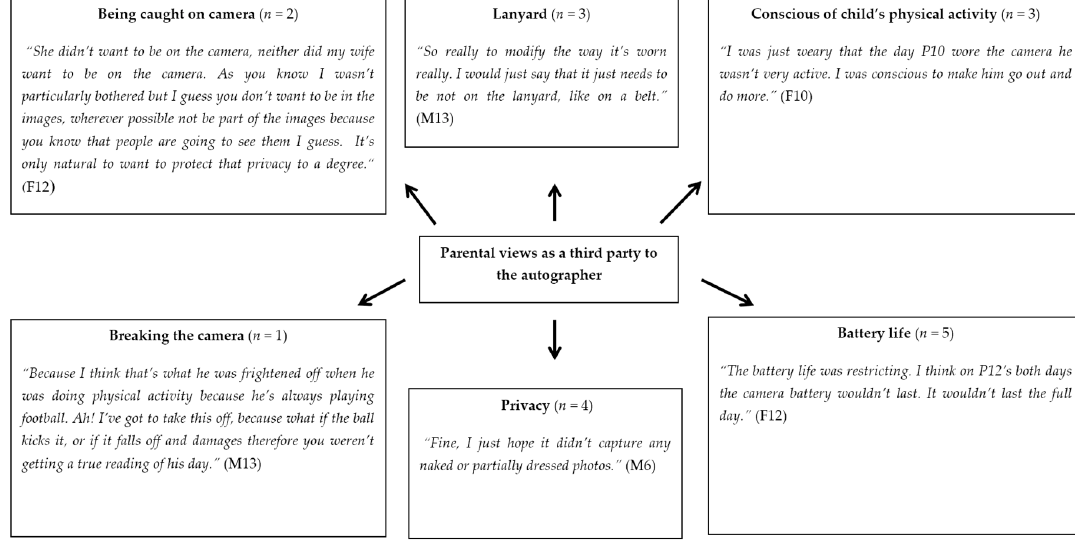
Figure 9. Pen profile illustrating parental views as a third party to the autographer (F = Father, M = Mother). n shows the number of individual responses.